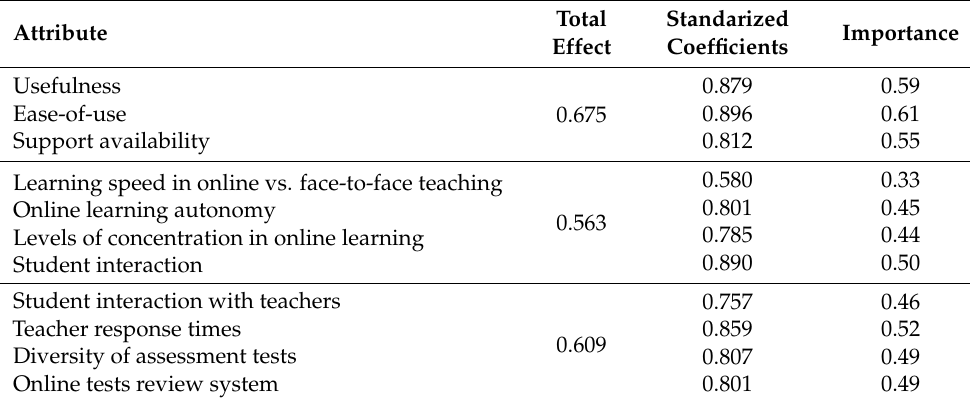
Table 8. Calculation of